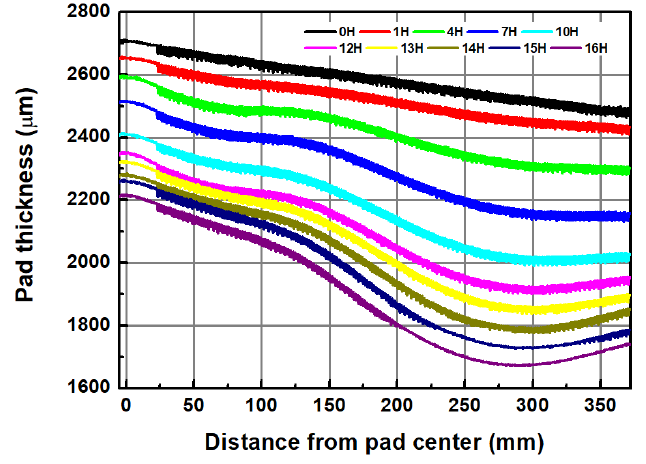
Figure 12. Pad thickness and profile change after conditioning for Case I.